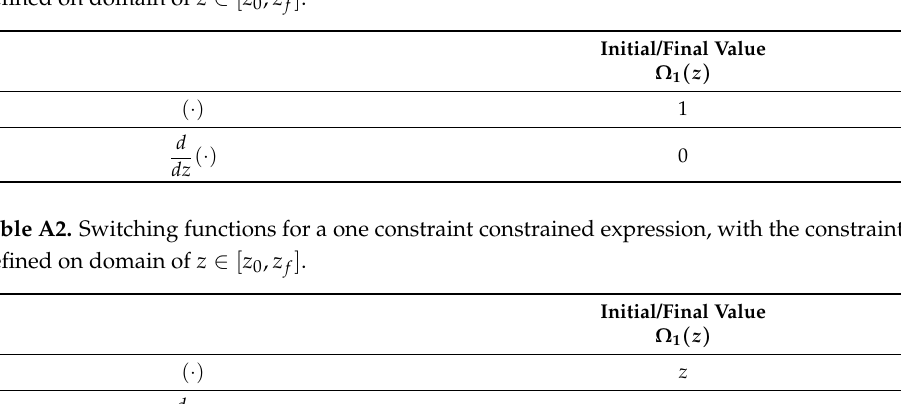
Table A1. Switching functions for a one constraint constrained expression, with the constraint of f , defined on domain of z ∈ [ z 0 , z f ] .